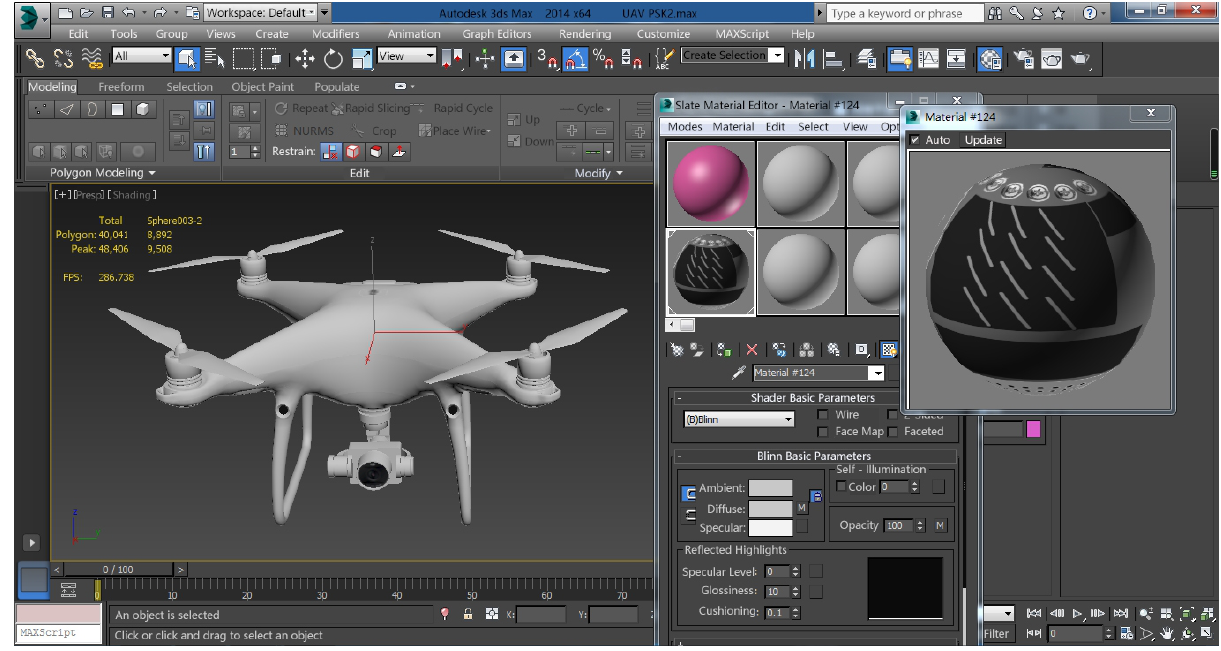
Figure 6. 3D modeling of UAV